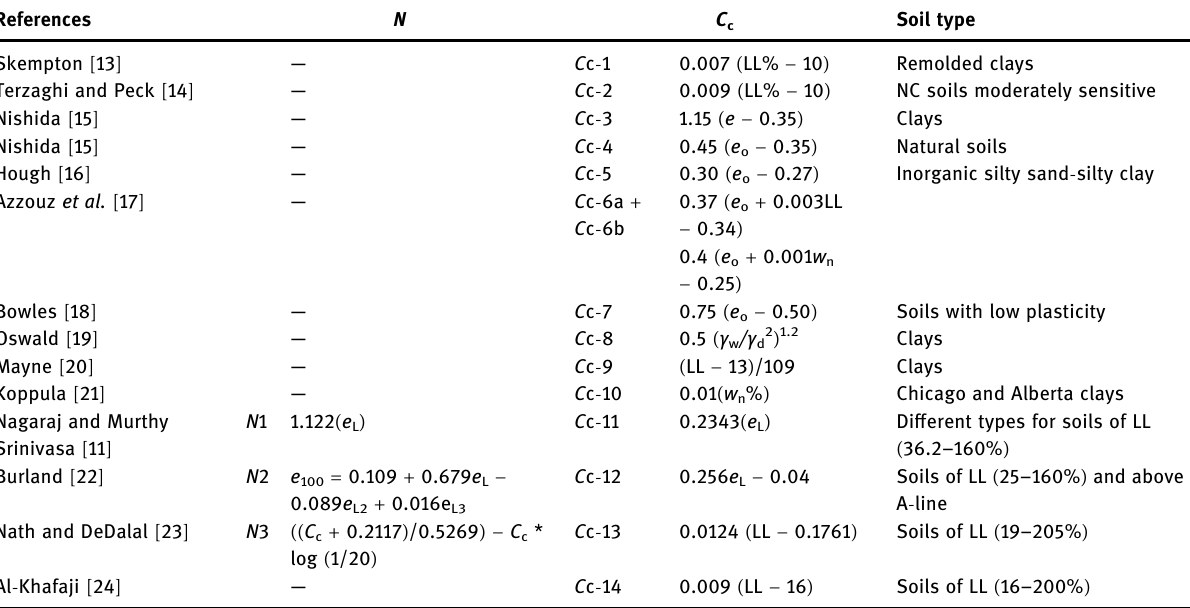
Table 1: Parameters of 1D - NCL equation ( N and C c ) for the previous